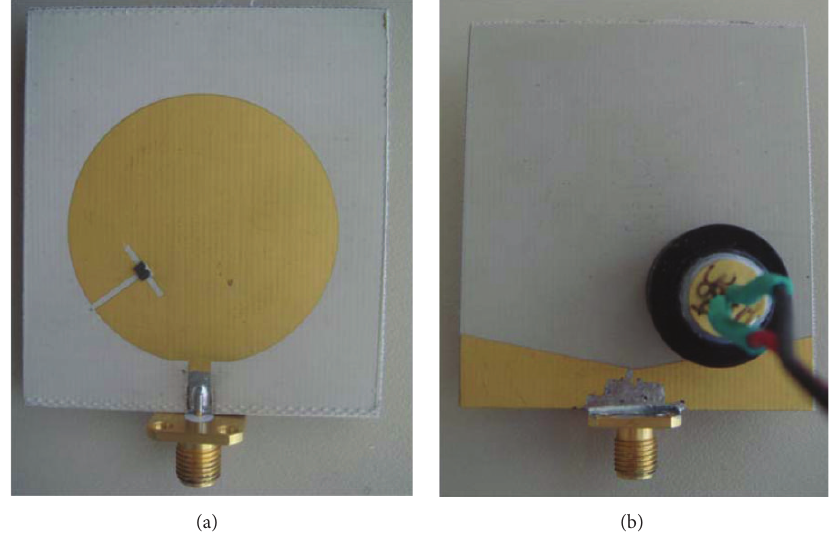
Figure 2: Front and back views of the antenna